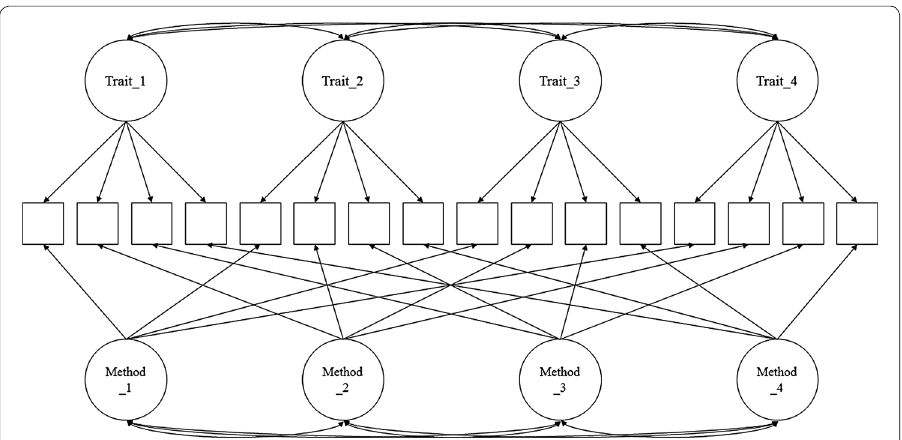
Fig. 1 An illustration of CT-CM model. (in case of assuming four factors on both facets) with categorical